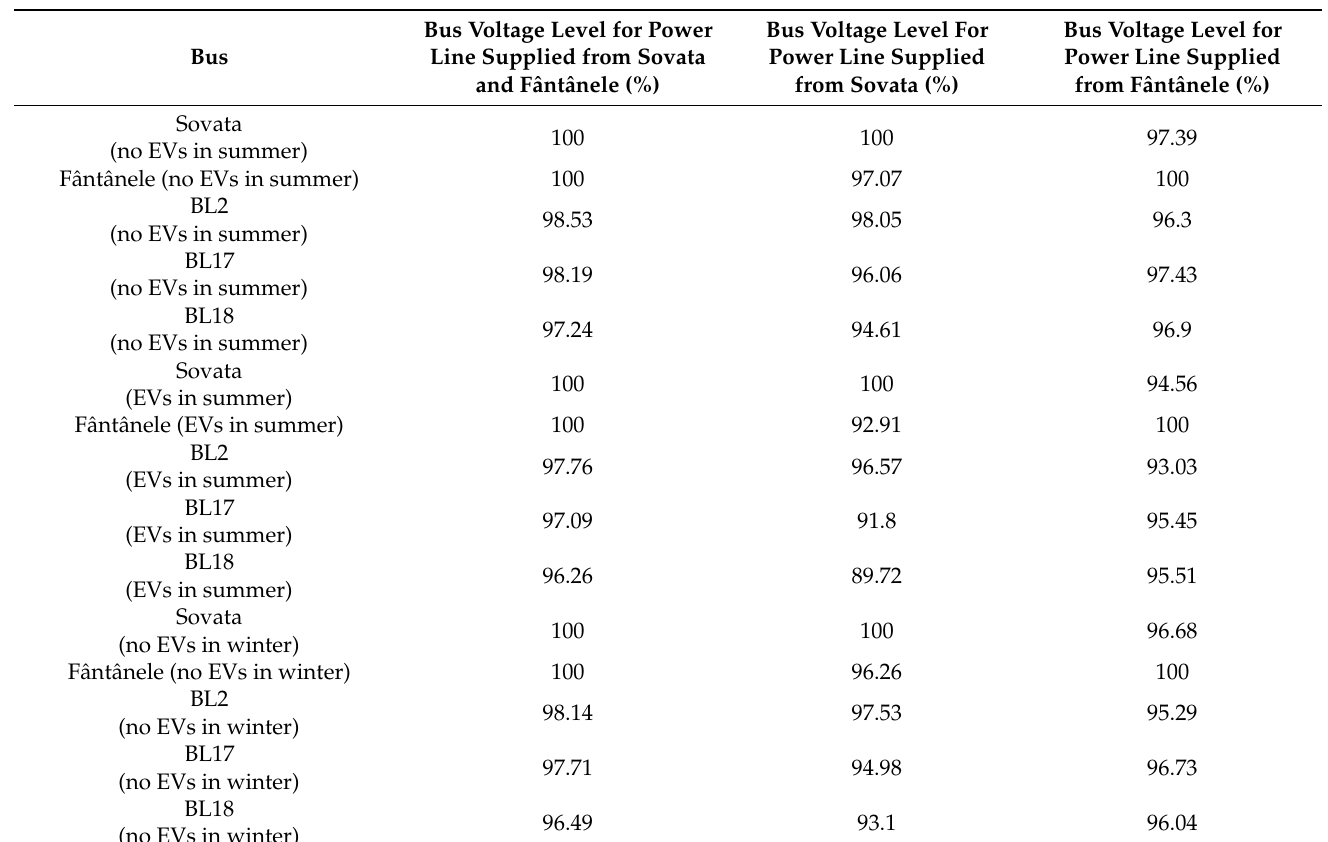
Table 34. Voltage level at 22:00 (scenario